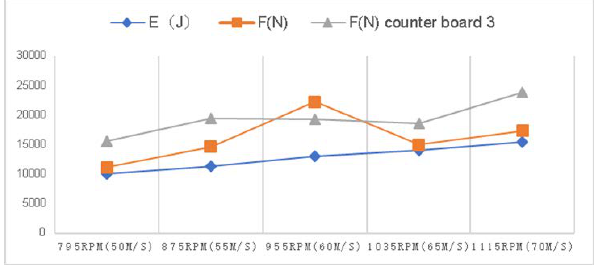
Fig. 14 Data of rotating